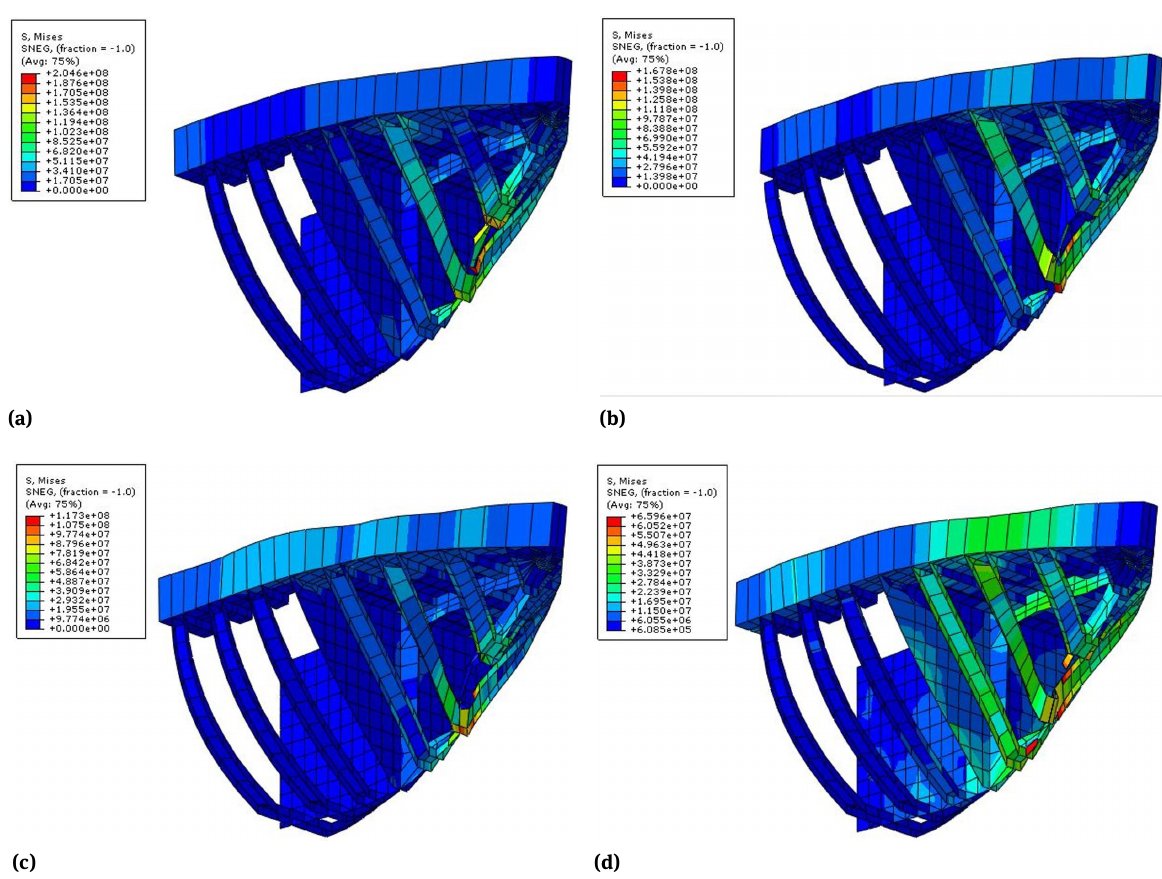
Figure 34: Deformation of the bow construction due to impact at a speed of 4 knots: (a) Type 1, (b) Type 2, (c) Type 3, (d) Type 4